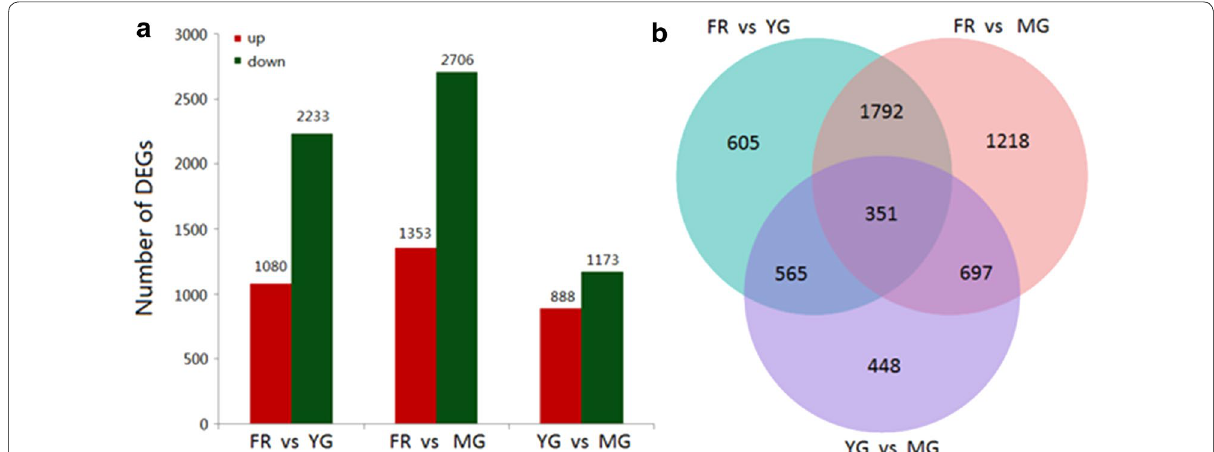
Fig. 2 Pairwise comparisons of unigene expression in ginger matured rhizome, young rhizome, and fibrous root libraries ( a ) and a Venn diagram of the differentially expressed genes (DEGs) among the three libraries ( b